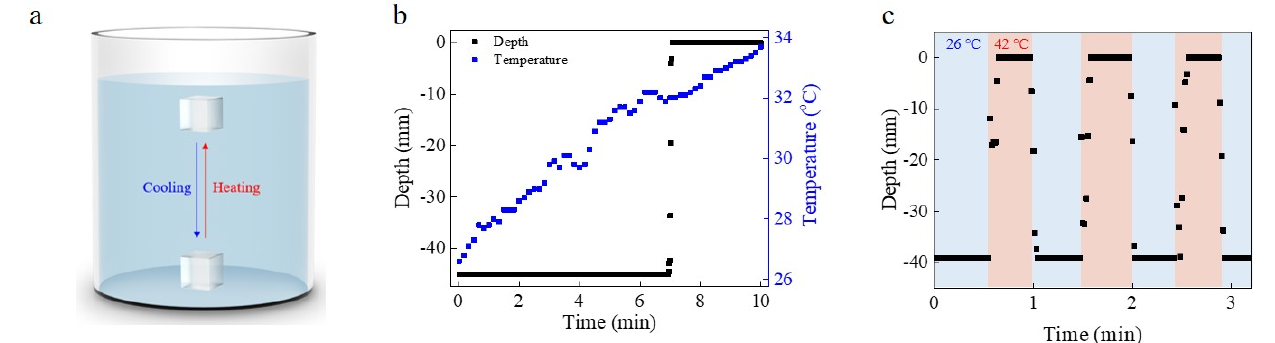
Figure 1. Diving/surfacing actuator fabricated using PNIPAM hydrogel. ( a ) Schematic image of diving/surfacing gel. The gel floats on the water when it is heated above its lower critical solution temperature (LCST) (32 °C) and sinks in the water if the temperature is lower than its LCST. ( b ) Raman spectrum of the device showing that the device consists of PNIPAM. ( c ) Diving/surfacing cycle in water. Diving motion occurred in a cool water bath (26 °C), and surfacing was produced in a hot water bath (42 °C).